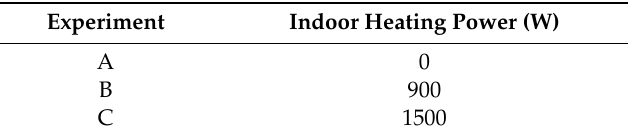
Table 2. Conducted experiments.